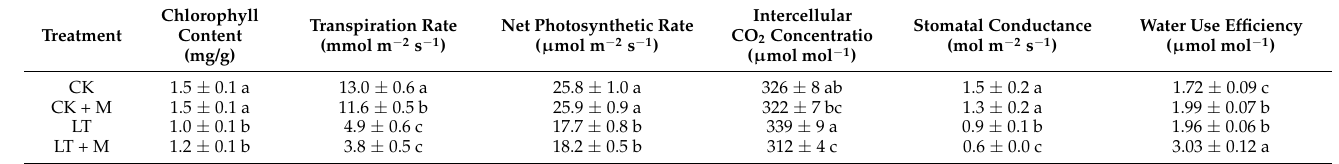
Table 2. Effects of wood vinegar on photosynthetic characteristics of rapeseed seedlings under low-temperature